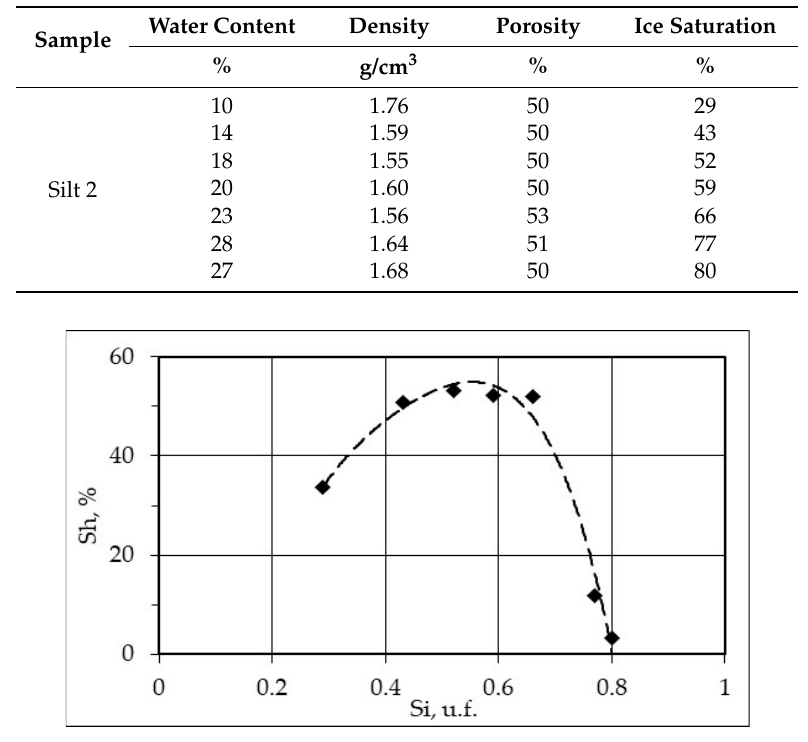
Figure 9. Effect of initial ice saturation ( Si ) in silt 2 on methane hydrate saturation ( Sh ) at (cid:442) 2.9 °C.